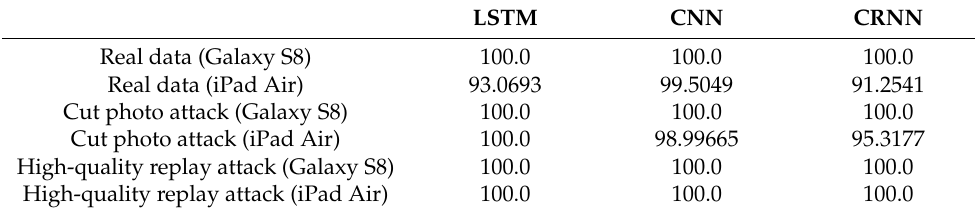
Table 4. Accuracy of each case with LSTM, CNN, and CRNN models